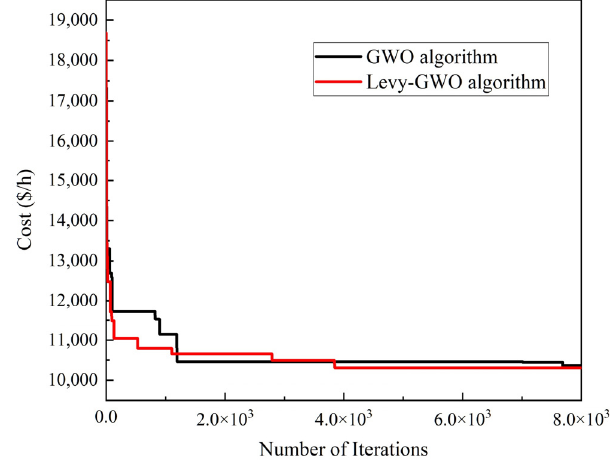
Figure 8. Convergence curve of GWO and Levy–GWO algorithms.